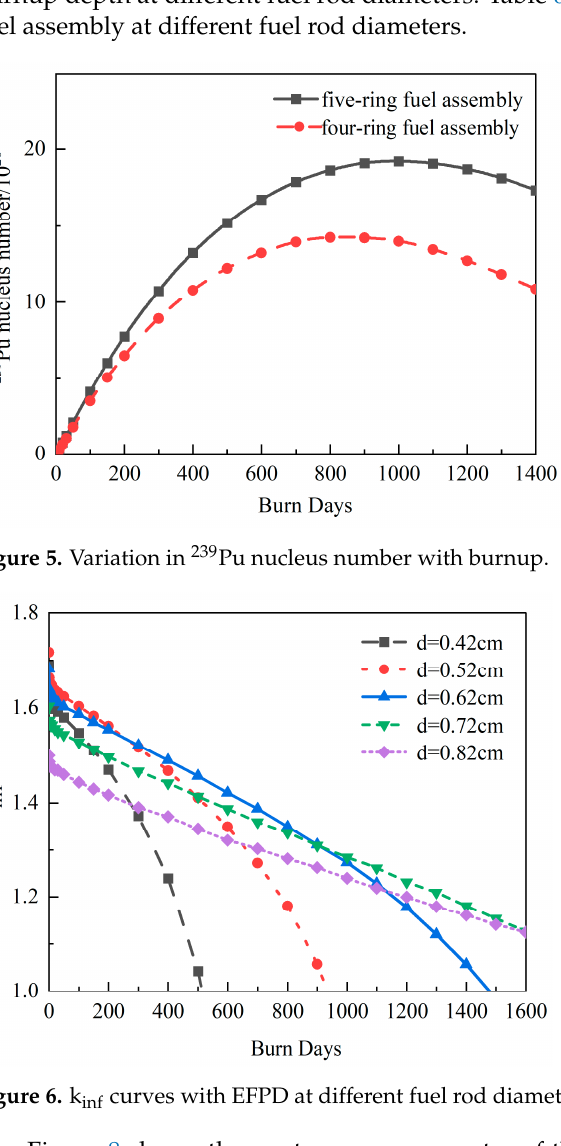
Figure 5. Variation in 239 Pu nucleus number with burnup.